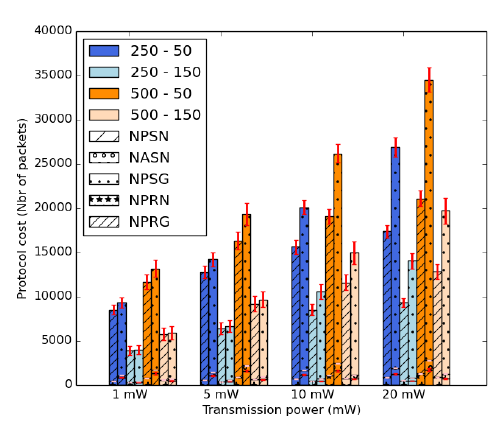
Figure 17. Average protocol